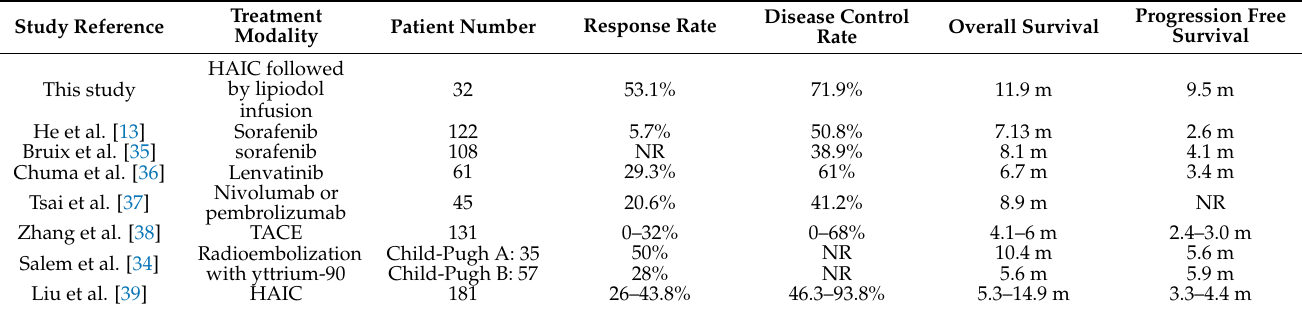
Table 5. Treatment modalities for advanced HCC with macrovascular invasion or portal vein tumor